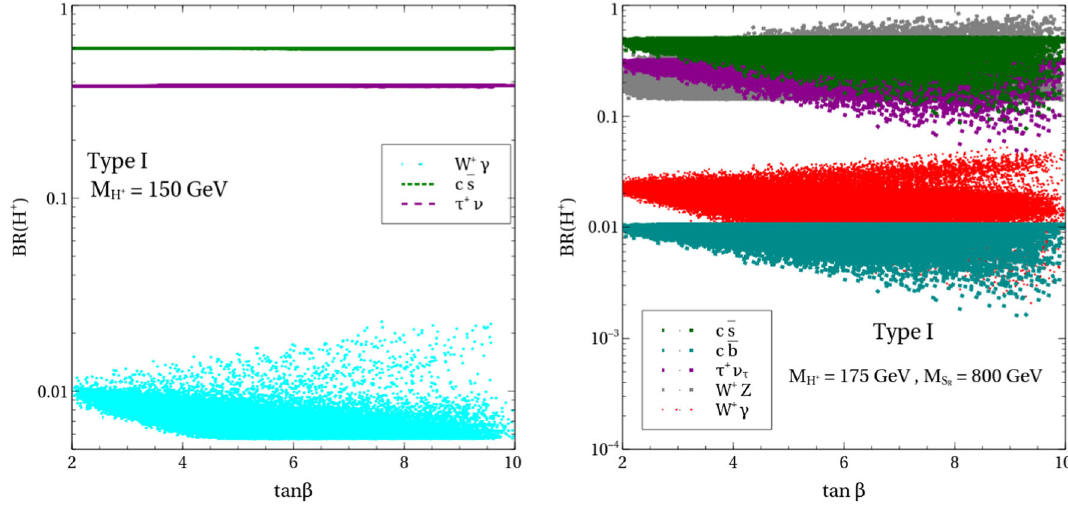
Fig. 12 Variation of the branching ratios of H + with tan β for M H + = 150 , 175 GeV for Type-I